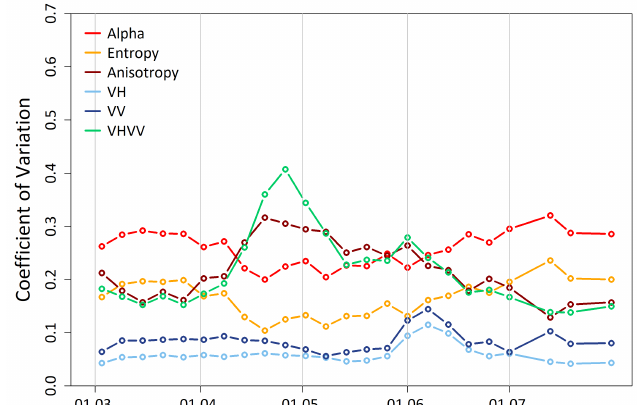
Figure 8. Temporal development of the coefficients of variation for all polarimetric and backscatter parameters: exemplarily shown are the mean values for barley fields